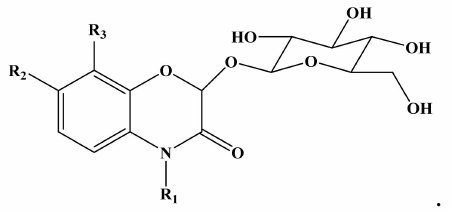
Figure 3. Benzoxazinone glucoside